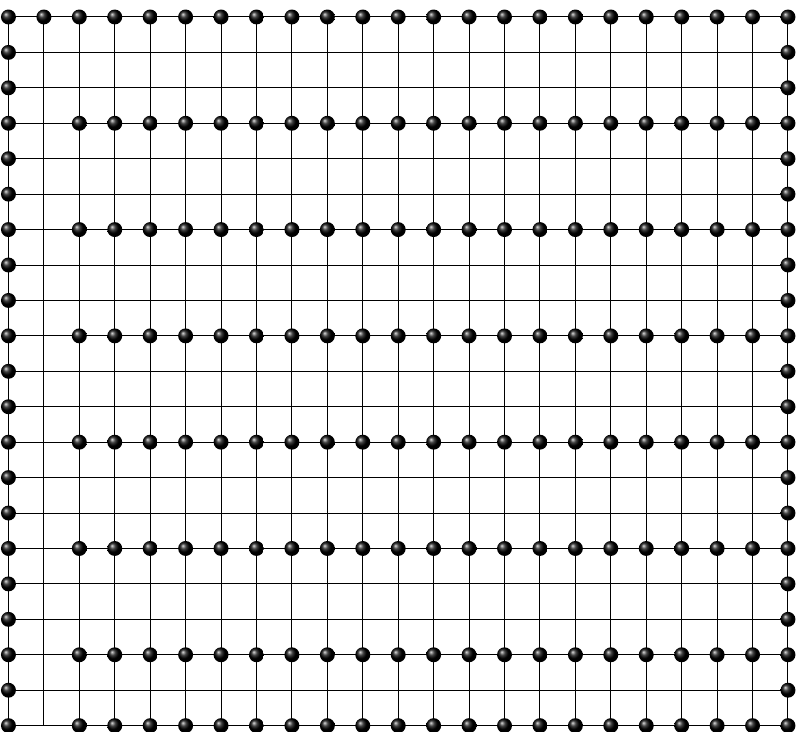
Figure 8. G [ 23,21 ] and a doubly connected dominating set. Nodes not belonging to the doubly connected dominating set are not marked and located at the intersections of the links without the black